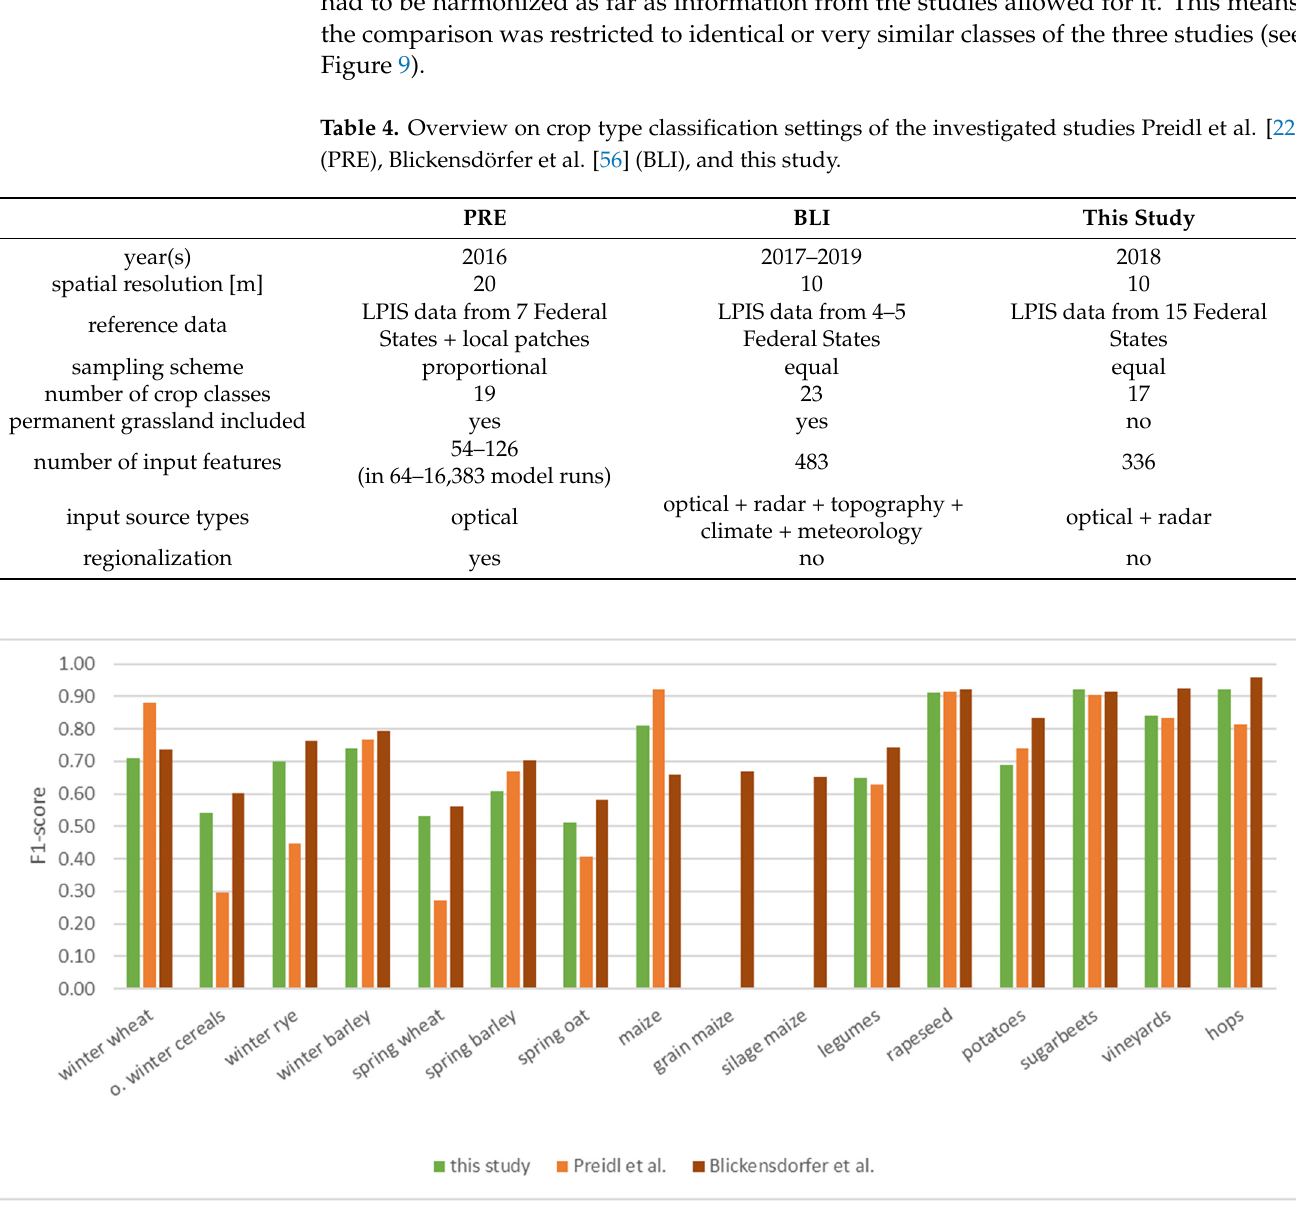
Figure 9. Comparison of class-wise model accuracies (F1-scores) achieved in the presented approach with the accuracy metrics from Preidl et al. [22] (PRE) and Blickensdörfer et al. [56] (BLI). The comparison is not perfect due to temporal and spatial mismatch, as well as partly different class definitions, different sampling schemes, and number of samples (see Table 4). It must be noted that the class “other winter cereals” comprises winter triticale and winter spelt in BLI and in this study, but only winter spelt in PRE, and that the class “spring wheat” also comprises spring triticale and spring rye in the case of